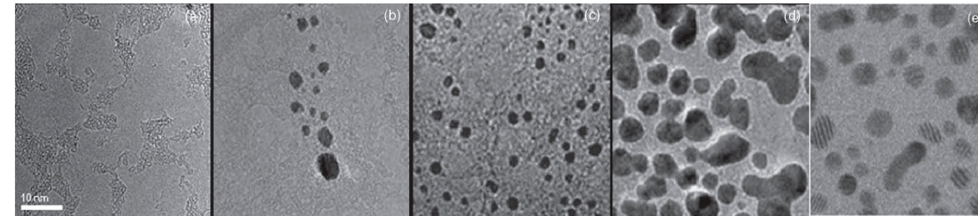
Figure 15. ( a – d ) Transmission Electron Microscopy images of Au deposited on free-standing graphene increasing the amount of deposited metal; ( a ) Sparse coverage; ( b ) sparse groups of clusters at Au thickness lower than 0.1 nm; ( c ) Higher cluster densities at 0.12 nm of Au thickness; ( d ) Coalescence of clusters occurring for 2.12 nm-thick deposited Au; ( e ) Scanning Transmission Electron Microscopy bright-field image of 0.5 nm-thick evaporated Au. Scale bar: 10 nm in all images. Reproduced from Reference [66] with permission from Wiley.